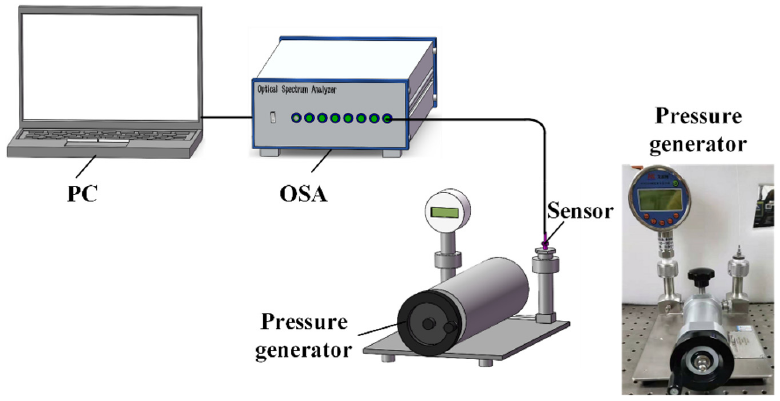
Figure 14. Experimental setup for pressure test.